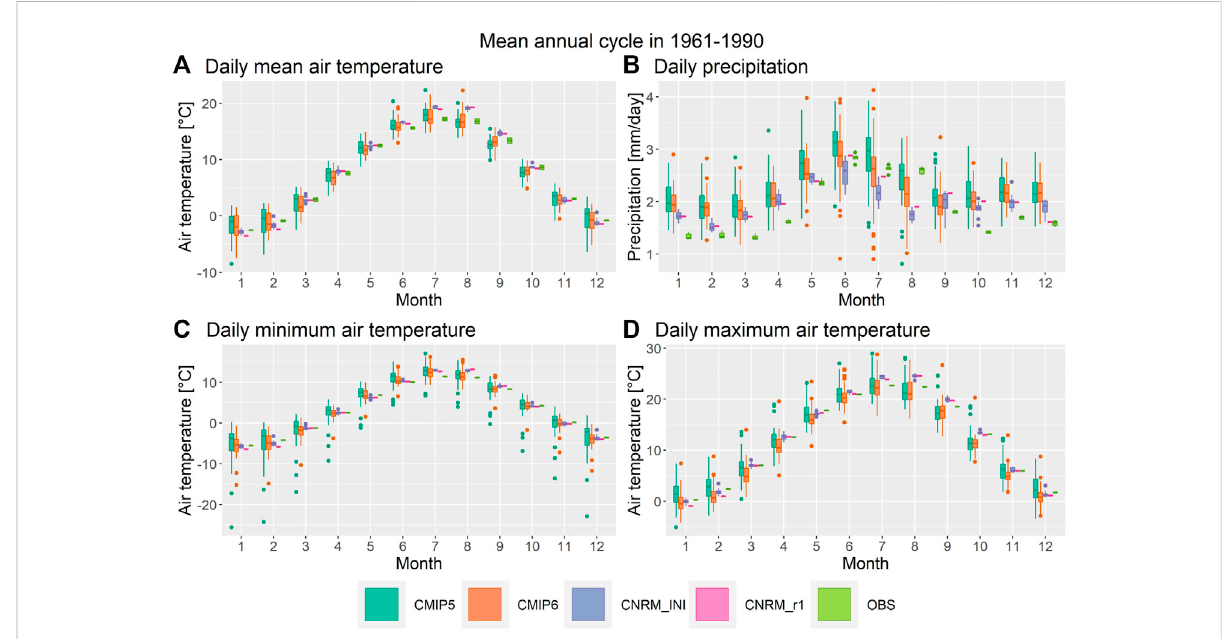
FIGURE 2 Mean annual cycle of monthly means of daily mean air temperature (A) , daily precipitation amount (B) , daily minimum air temperature (C) and daily maximum air temperature (D) in the period 1961 – 1990 averaged over the studied area (see Figure 1). Boxplots show intra-ensemble statistical distribution (median, lower and upper quartiles, whiskers representing 1.5 * IQR, and outliers as dots) of CMIP5 (green), CMIP6 (orange), perturbed initial conditions mini-ensemble of CNRM-ESM2-1 model (CNRM_INI, 10 members, blue) and observations (consisting of EOBS v. 23.1 in both 0.1 ° and 0.25 ° resolutions, for daily mean air temperature and precipitation also CRU TS 3.22 and CRU TS 4.05 datasets, for precipitation also GPCC version 7 datasets in two spatial resolutions (1 ° and 0.5 ° ), green). The CNRM-ESM2-1 r1i1p1f2 simulation is plotted as a pink